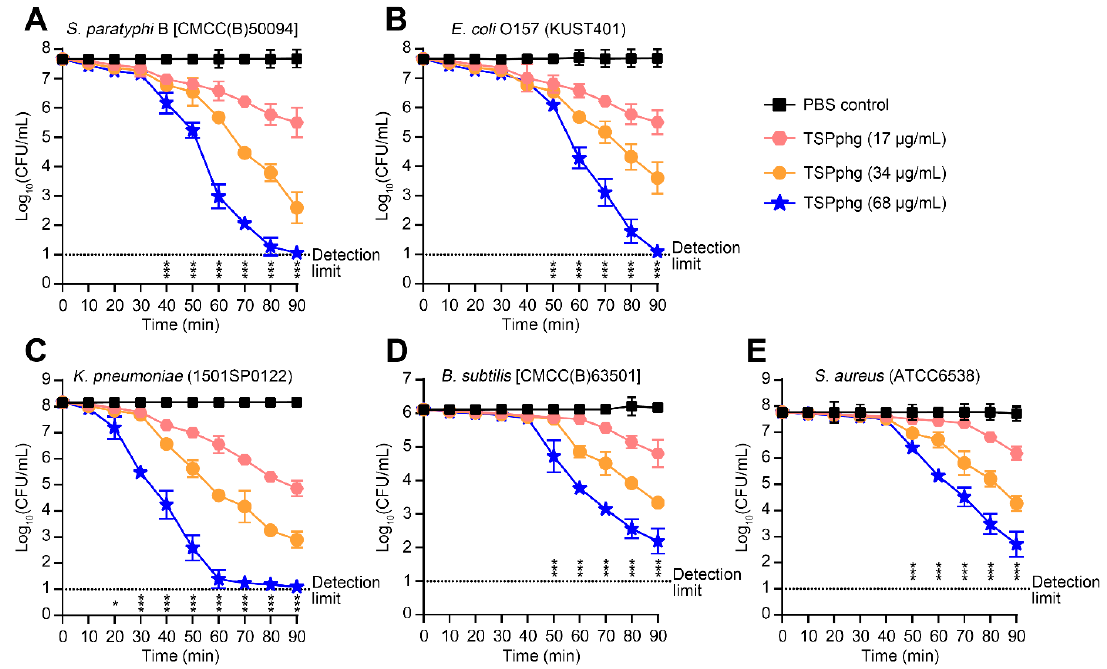
Figure 2. Time-kill assays. Antimicrobial activity of TSPphg against Salmonella paratyphi B ( A ), Escherichia coli O157 ( B ), Klebsiella pneumoniae ( C ), Bacillus subtilis ( D ) and Staphylococcus aureus ( E ). S. paratyphi B, E. coli O157 and K. pneumoniae are Gram-negative bacteria while B. subtilis and S. aureus are Gram-positive bacteria. Bacterial cell numbers were counted as Log 10 ( CFU/mL ) at different time points as denoted. CFU means colony-forming unit. Data were presented as mean ± standard deviation ( n = 3) and were analyzed using one-way analysis of variance (ANOVA) with a Bonferroni correction. *, p < 0.05; ***, p < 0.001. The dotted line shows the limit of detection (<10 CFU/mL).